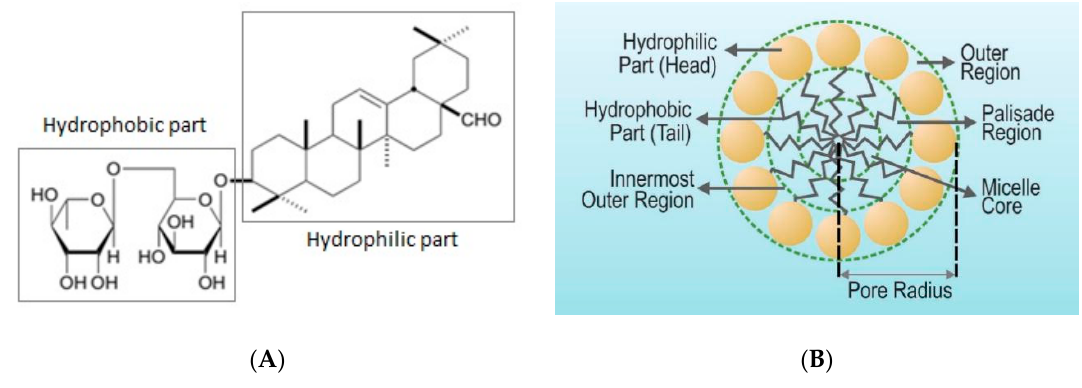
Figure 1. ( A ) Part of saponin; ( B ) Part of surfactant micelle in water.